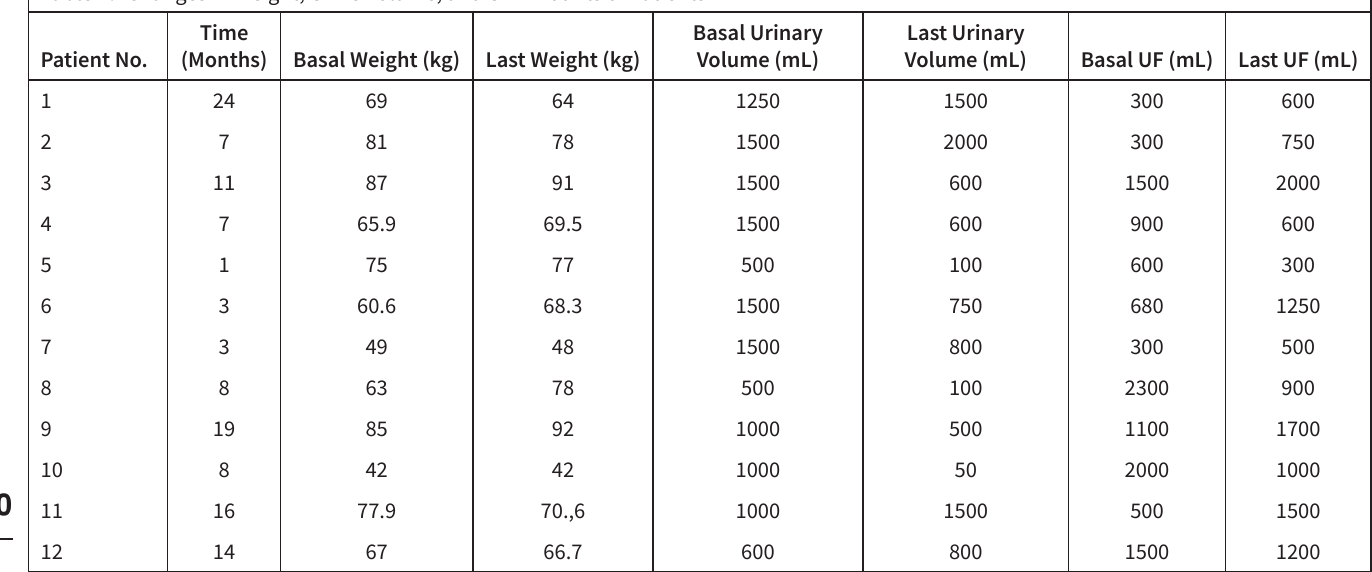
Table 4. Changes in Weight, Urine Volume, and UF Amounts of Patients Patient No.